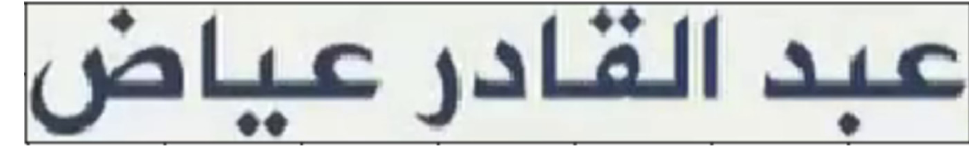
Figure 7. Original image.